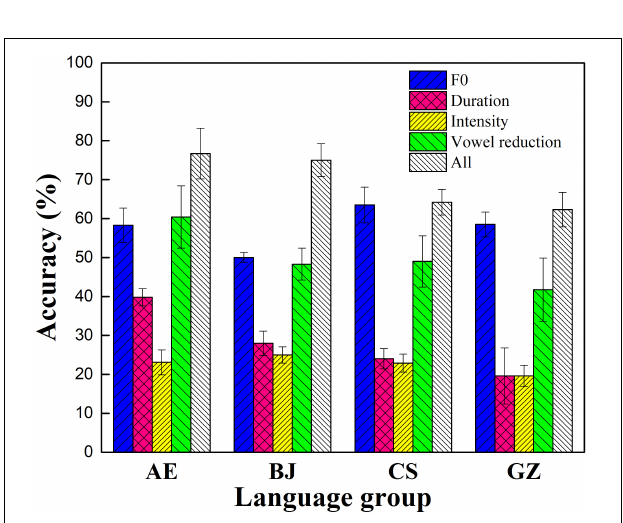
FIGURE 3 | Participants’ sequence-encoding accuracy of the five conditions.